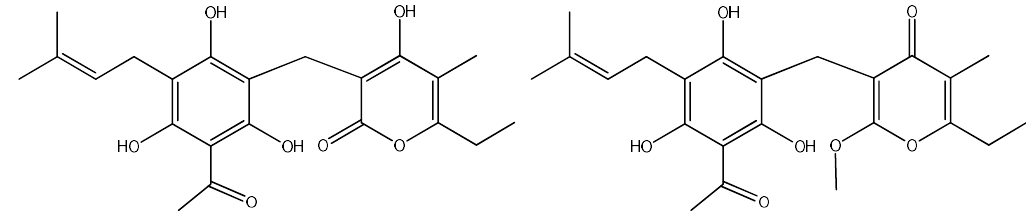
Figure 2. Structures of arzanol (left) and methylarzanol (right).